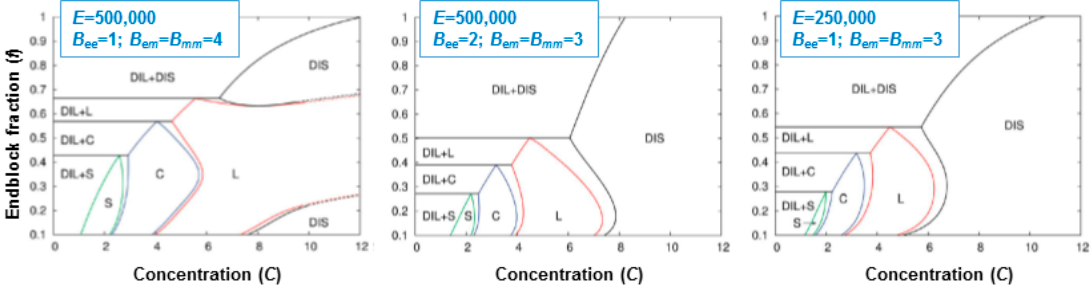
Figure 11. Phase diagrams of mixtures of triblock copolymers with a hydrophilic middle block and oppositely charged end blocks, calculated using the embedded fluctuation model. The morphologies are given in dependence on polymer number concentration and on the endblock fraction for different sets of parameters. E is the electrostatic strength parameter. DIS denotes a polymer rich homogeneous phase, DIL a nearly pure water phase, L lamellae, C hexagonally packed cylinders and S cubically packed spheres (body-centered or face-centered). Adapted with permission from [43]. Copyright 2015 Royal Society of Chemistry.